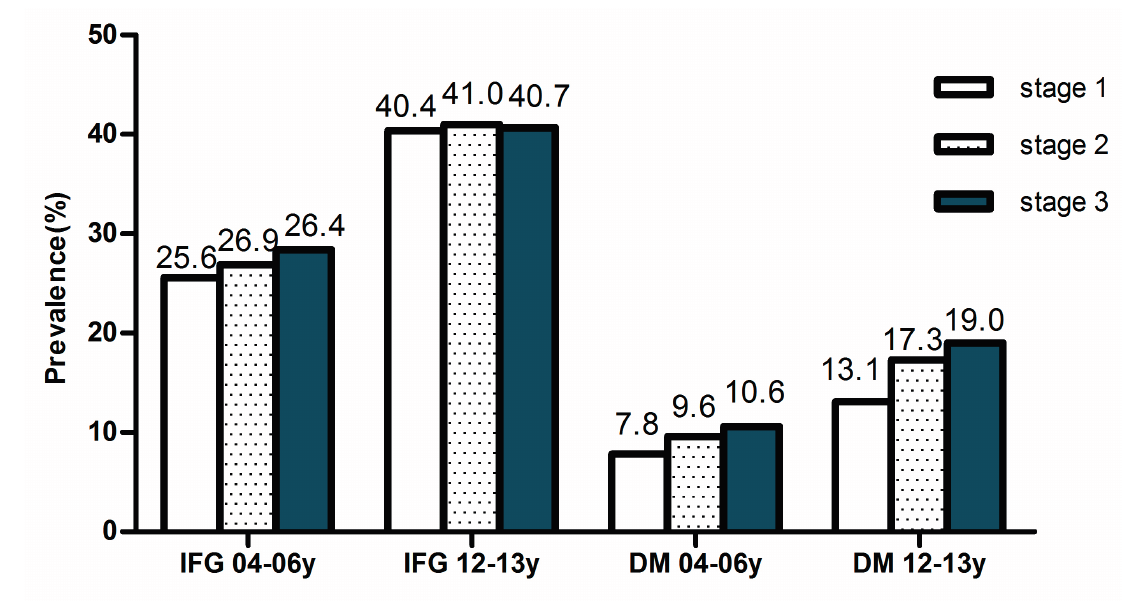
Figure 3. Prevalence of diabetes and IFG by classification of blood pressure. 04–06y means from 2004–2006 years, 12–13y means form 2012–2013 years. Table 3. Risk factors for diabetes and IFG determined by multinomial logistic regression analysis. Diabetes * IFG Variables